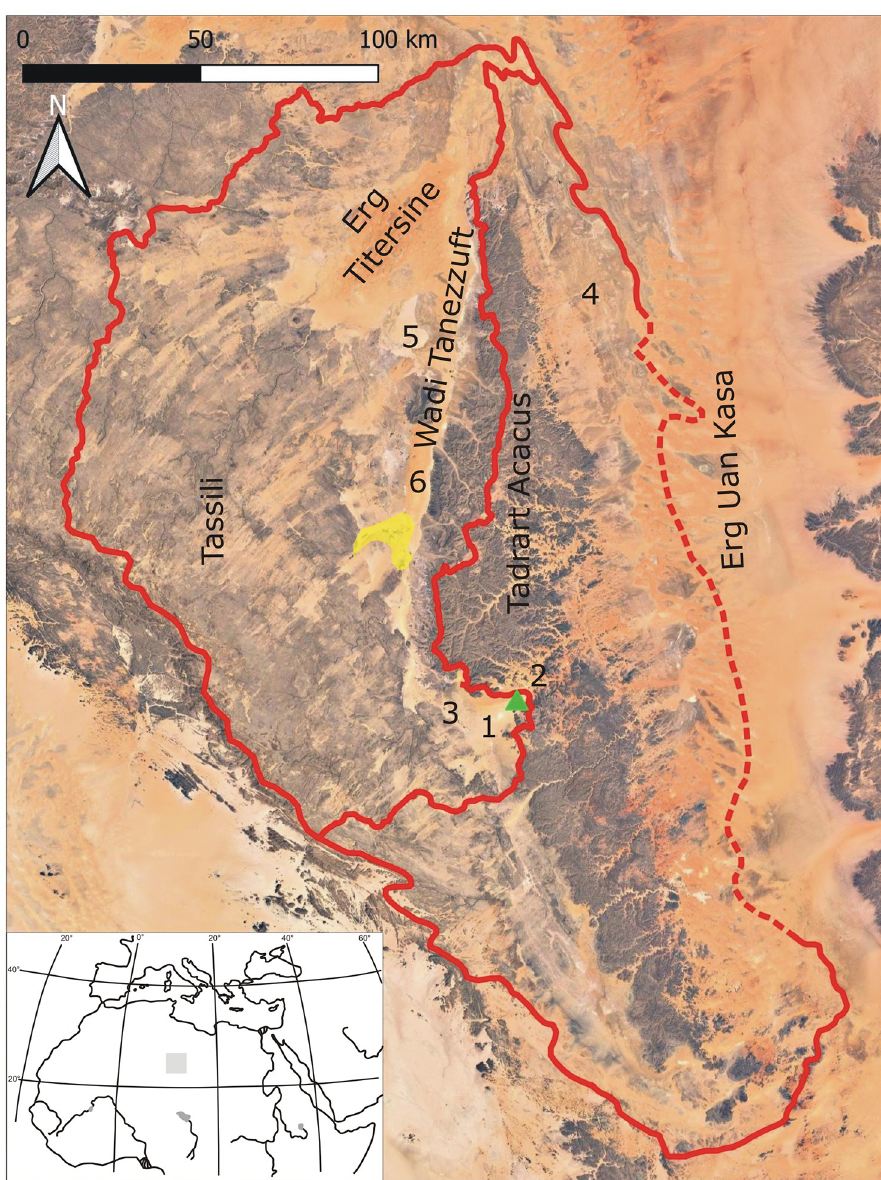
Fig 1. Landsat satellite imagery of the study region indicating the main localities cited in the text and reporting the limits of the two drainage basins considered (dashed line indicates an uncertain limit of the basin); the triangle indicates the position of the Takarkori rock shelter and the yellow shadow the Ghat/el Barkat/Fewet oases system. Numbers relate to former wetlands: 1) Takarkori Lake; 2) Bubu Lake; 3) Wadi Takarkori; 4) Awiss marshes; 5) Garat Ouda Lake; 6) Erg